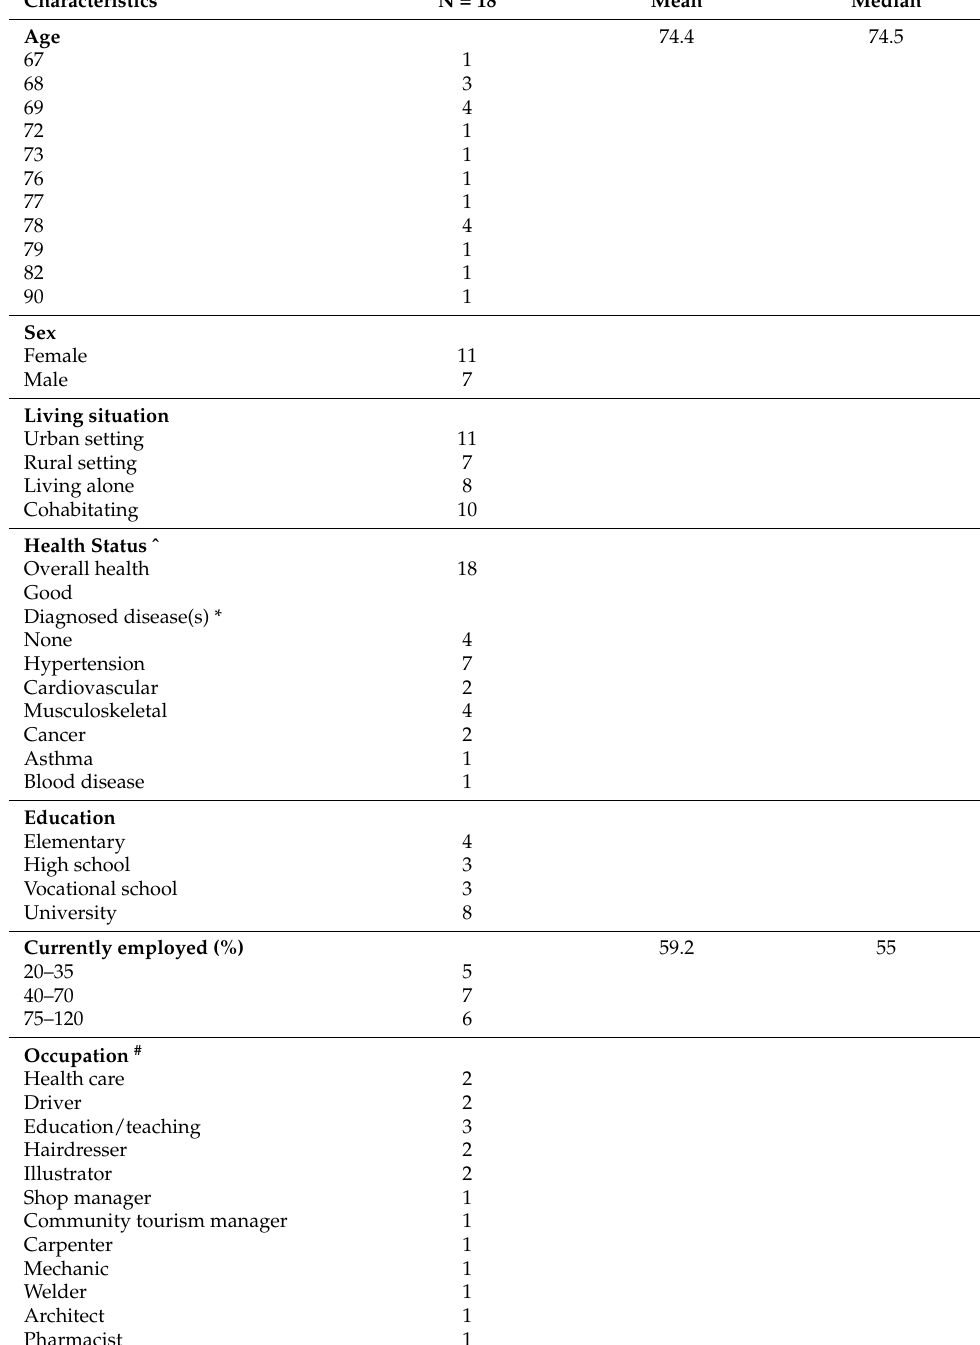
Table 1. The participants’